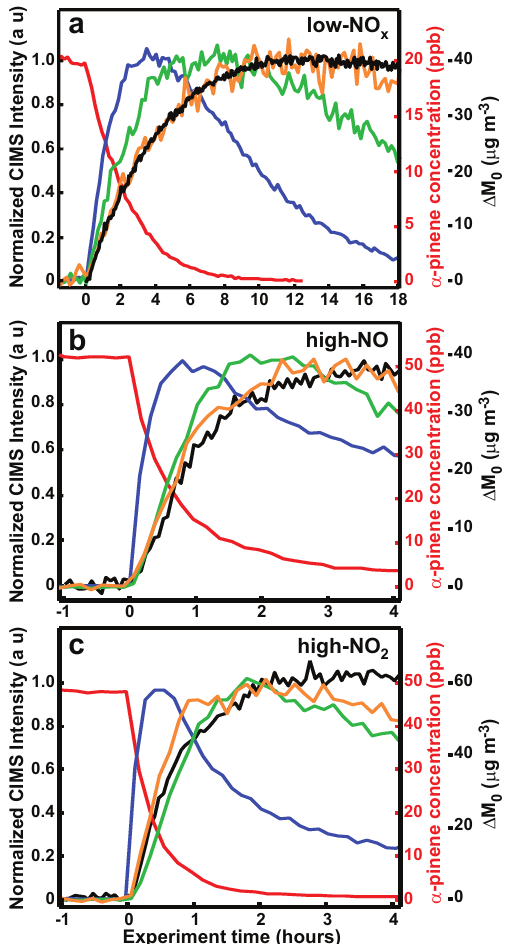
Fig. 2. Time evolution of SOA growth along with gas-phase time profile of first- and second-generation products of OH oxidation of α -pinene under (a) low-NO x conditions (7-H2O2), (b) high-NO conditions (4-HONO), and (c) high-NO 2 conditions (10-MeONO). In all plots, the red line is α -pinene, blue line is pinonalde- hyde, and black line is SOA growth. In (a) green is 10-hydroxy pinonic/pinonic peracid acid and orange is pinonic acid, (b, c) green is pinonaldehyde-PAN, and orange is pinonaldehyde nitrate.